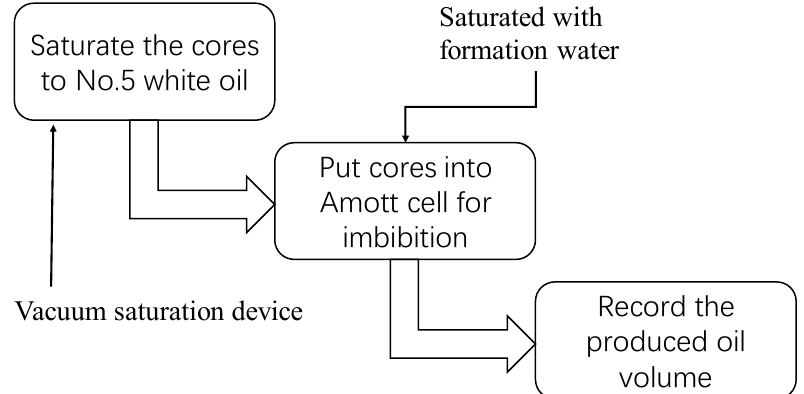
Figure 1. The schematic/workflow of the experiment.